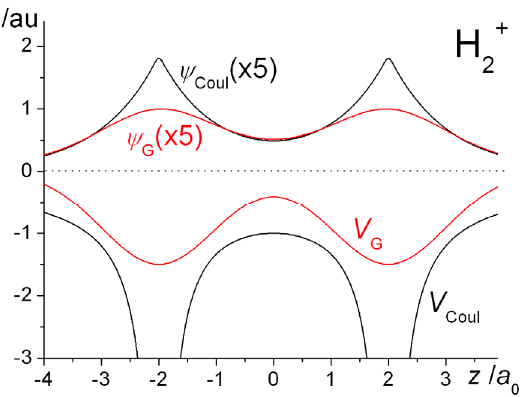
Figure 9. Gaussian (G) ( α = 0.5, A = 1.5) and Coulomb (Coul) potentials of H 2 + and the resulting ground state wave functions (with ζ = 1 in both cases) at R = 4 a 0 as functions of the internuclear coordinate z ( x = y = 0).